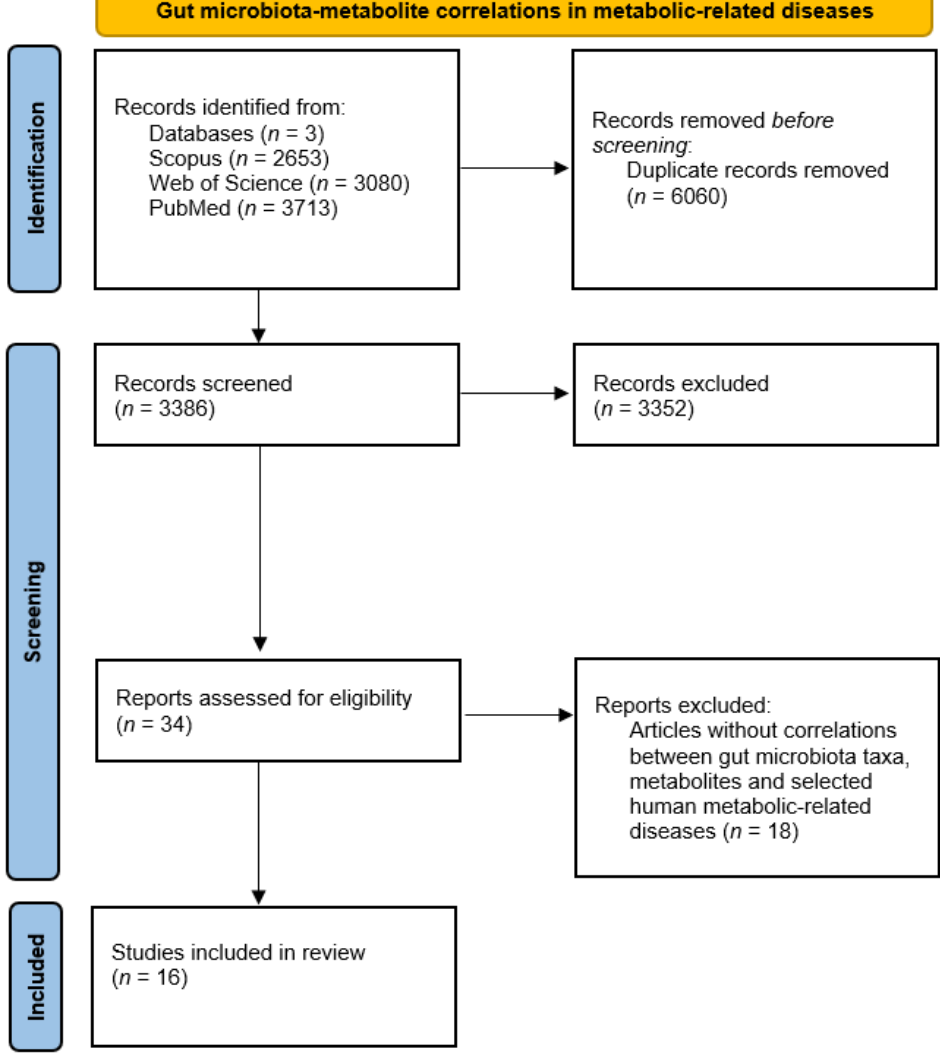
Figure 4. PRISMA diagram for gut microbiota – metabolite correlations and host status.